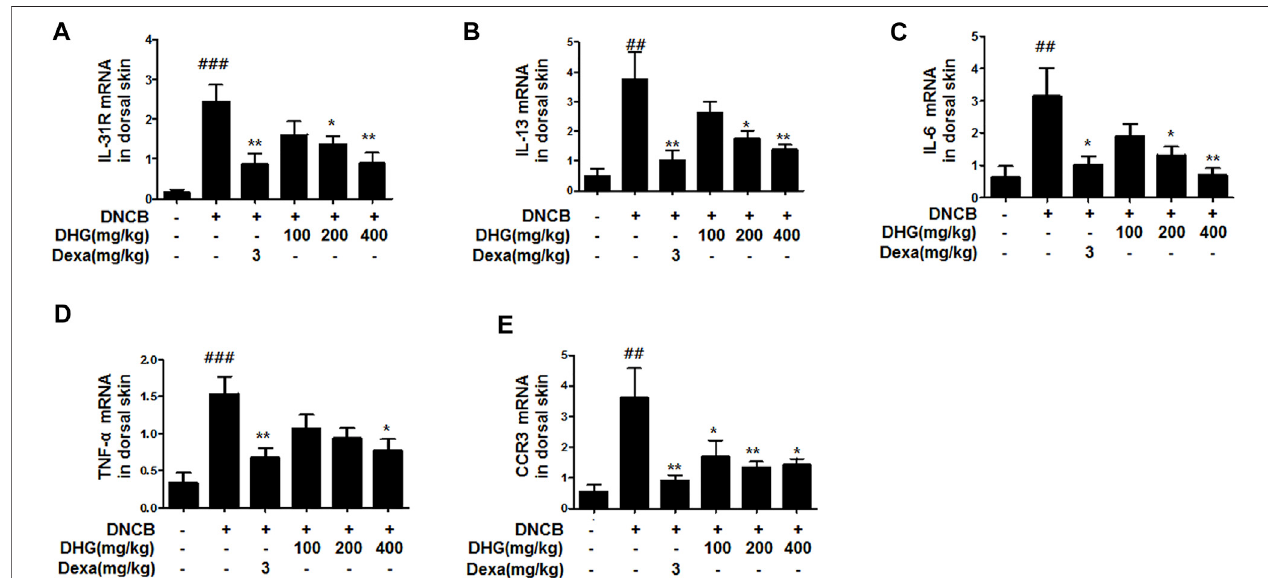
FIGURE 3 | Effects of DHG on IL-31R (A) , IL-13 (B) , IL-6 (C) , TNF- α (D) , and CCR3 (E) and CCR3 mRNA expression in dorsal skin tissue (total n = 6/group). Total RNAs were extracted in dorsal skin tissue and IL-31R, IL-13, CCR3, IL-6, and TNF- α mRNA expression was analyzed by real-time PCR. The cycle number at which the emissionintensityofthesamplerisesabovethebaselineisreferredtoastheRQ(relativequantitative)andisproportionaltothetargetconcentration.Real-timePCRwas performed in duplicate and analyzed by Applied Biosystems 7,500 Fast Real-Time PCR system. # p < 0.05, ## p < 0.01, ### p < 0.001 (compared with NC/Nga-Nr). * p < 0.05, ** p < 0.01, and *** p < 0.001 (compared with